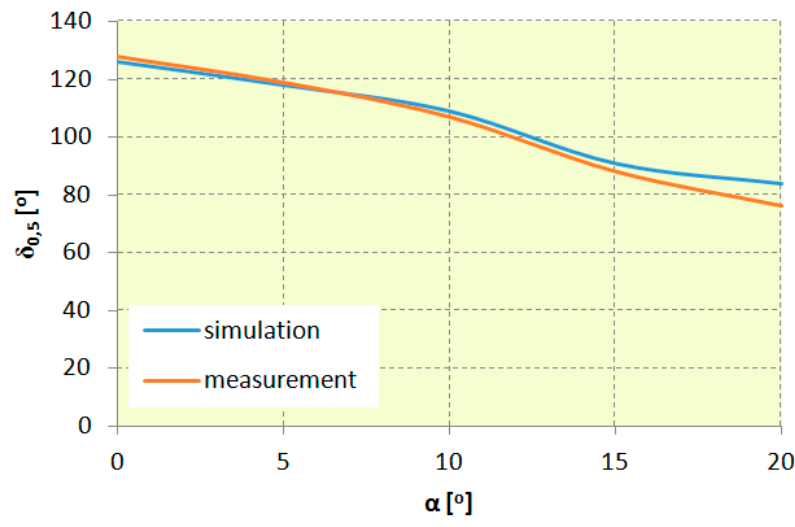
Figure 24. The comparison of beam angles of a light-optical system obtained in simulations and by prototype measurements in the function of reflector’s inclination angle.